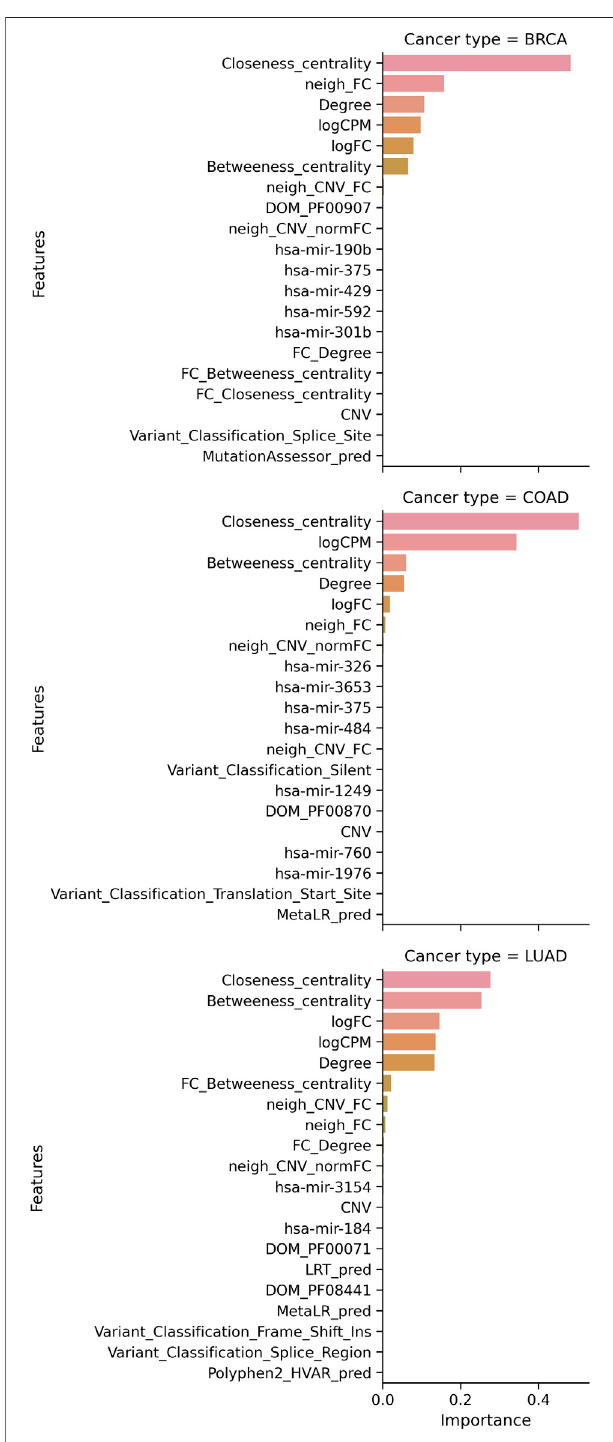
FIGURE4| Multi-omicfeaturescontributingtothebestmodelforcancer type. For each cancer type, the contribution of the top 20 features is plotted.